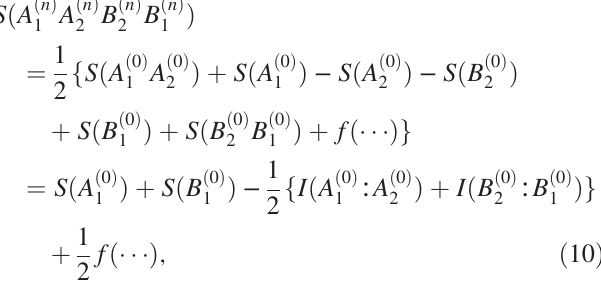
entropic relations between the subregions while changing their sizes. The size of each region is denoted by l , with the corresponding subscript as in the caption of the figure. We denote the reduced density matrix by ρ , with the corresponding superscript, e.g., ρ C ¼ Tr similar convention for other density matrices. The von Neumann entropy of a local region is denoted, e.g., by S ð C Þ ¼ S ð ρ C Þ , etc.